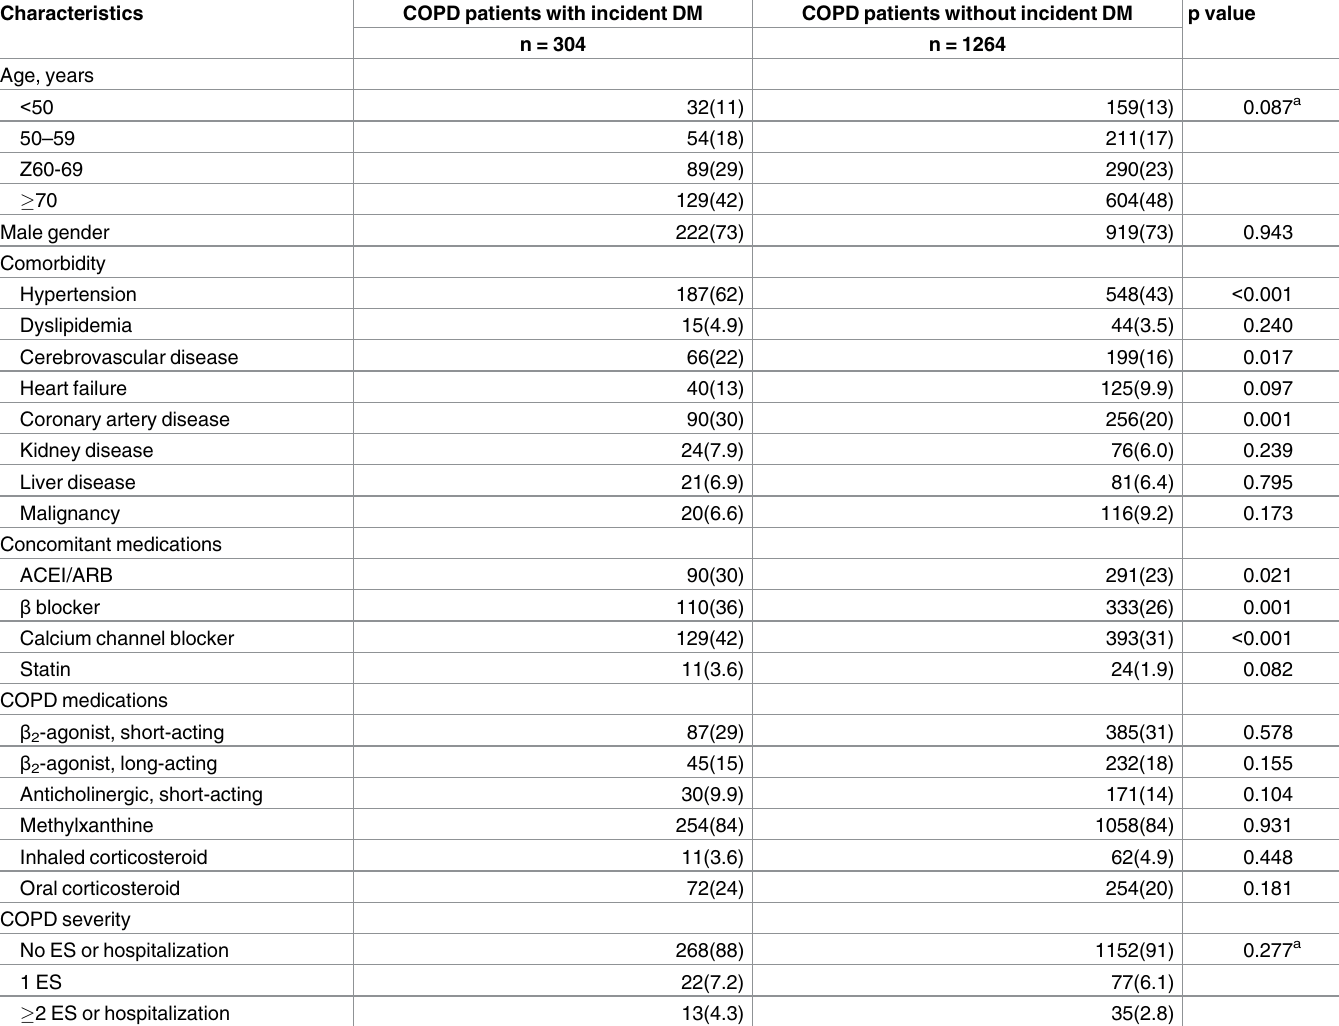
Table 3. Comparison of featuresbetween COPD patients with and without incident DM (n = 1568).